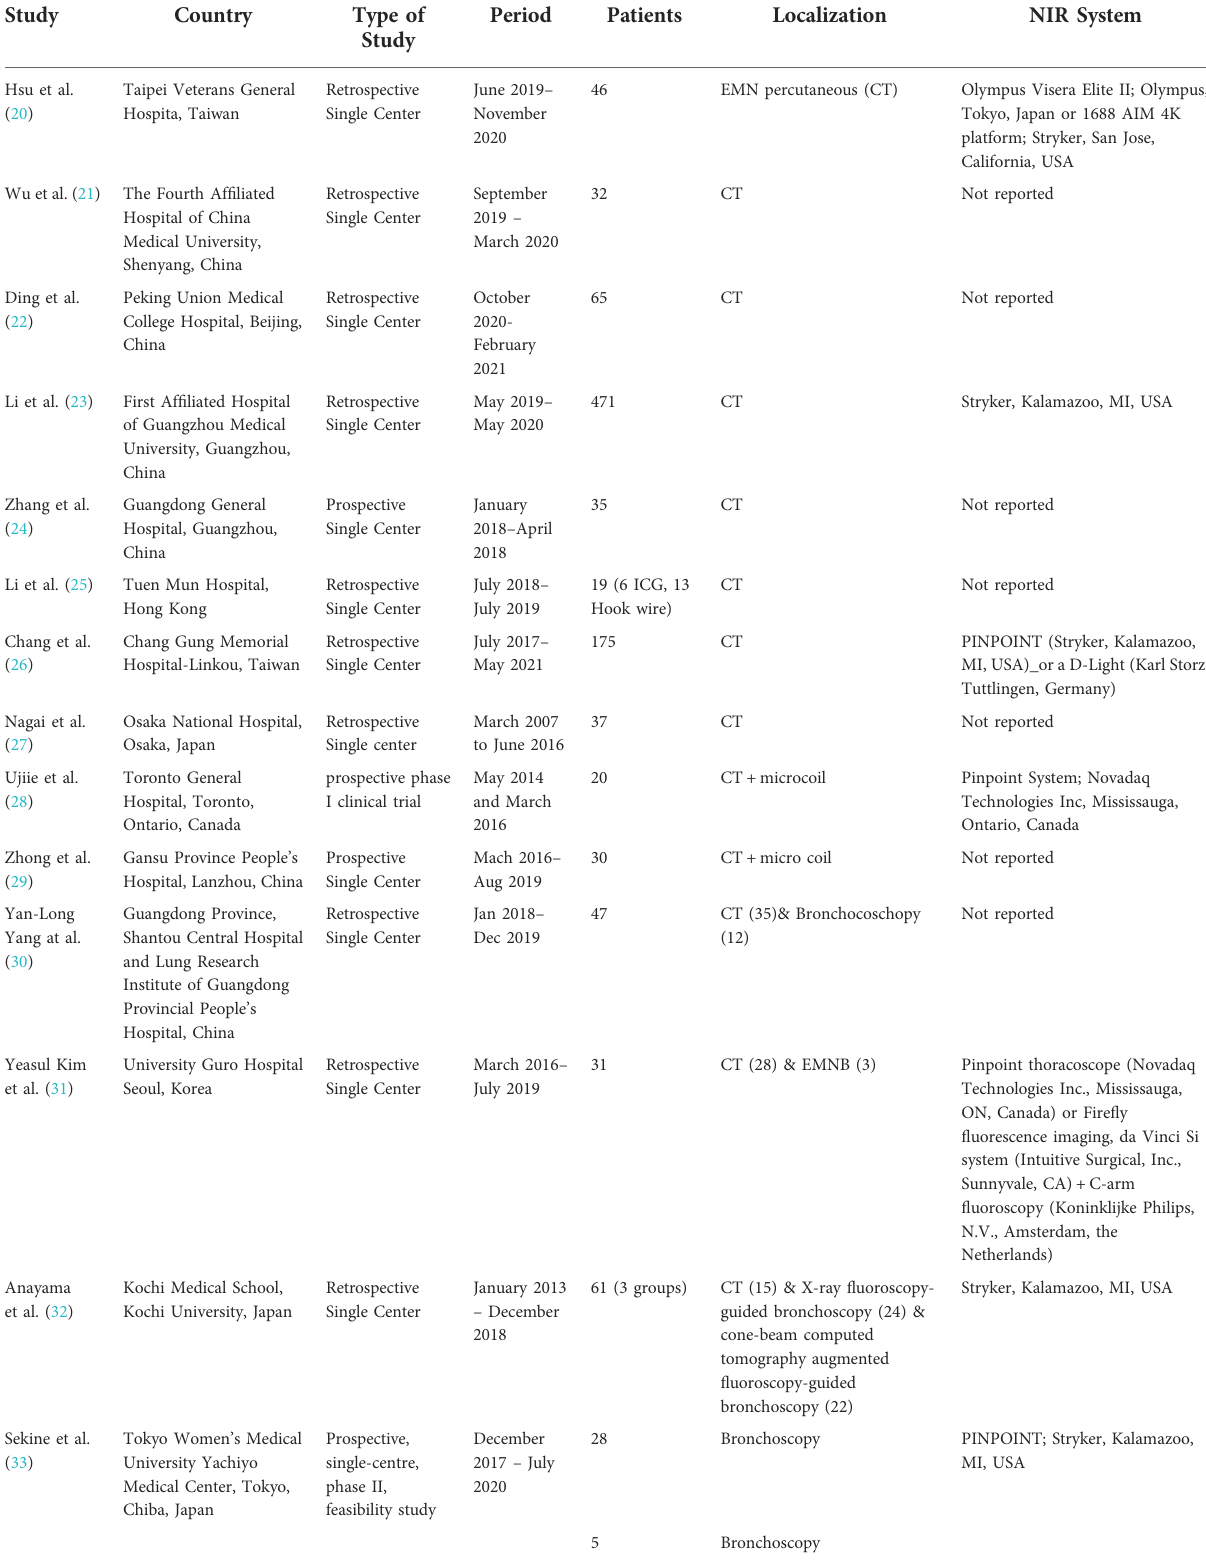
TABLE 1 Characteristics of the included